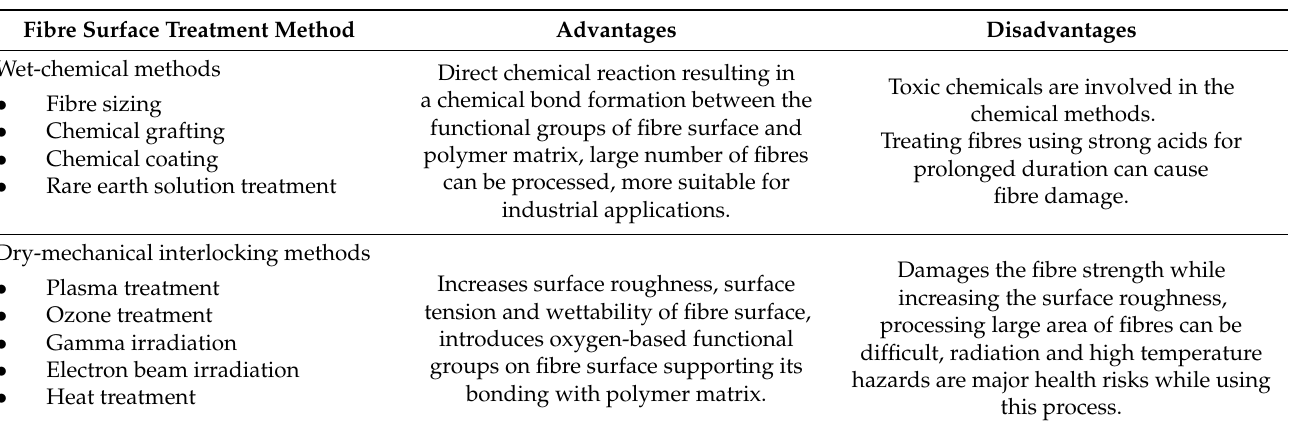
Table 4. Advantages and disadvantages of various fibre surface treatment